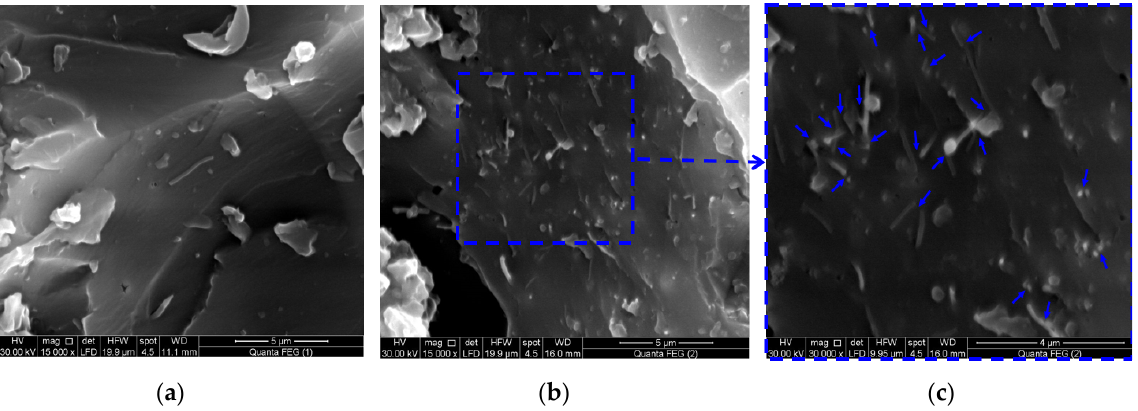
Figure 4. SEM images of CNFs in the epoxy matrix; ( a ) 0.5 wt.%; ( b ) 2.0 wt.%; and ( c ) a close view of 2.0 wt.% CNFS shows the formation of conductive network inside epoxy.